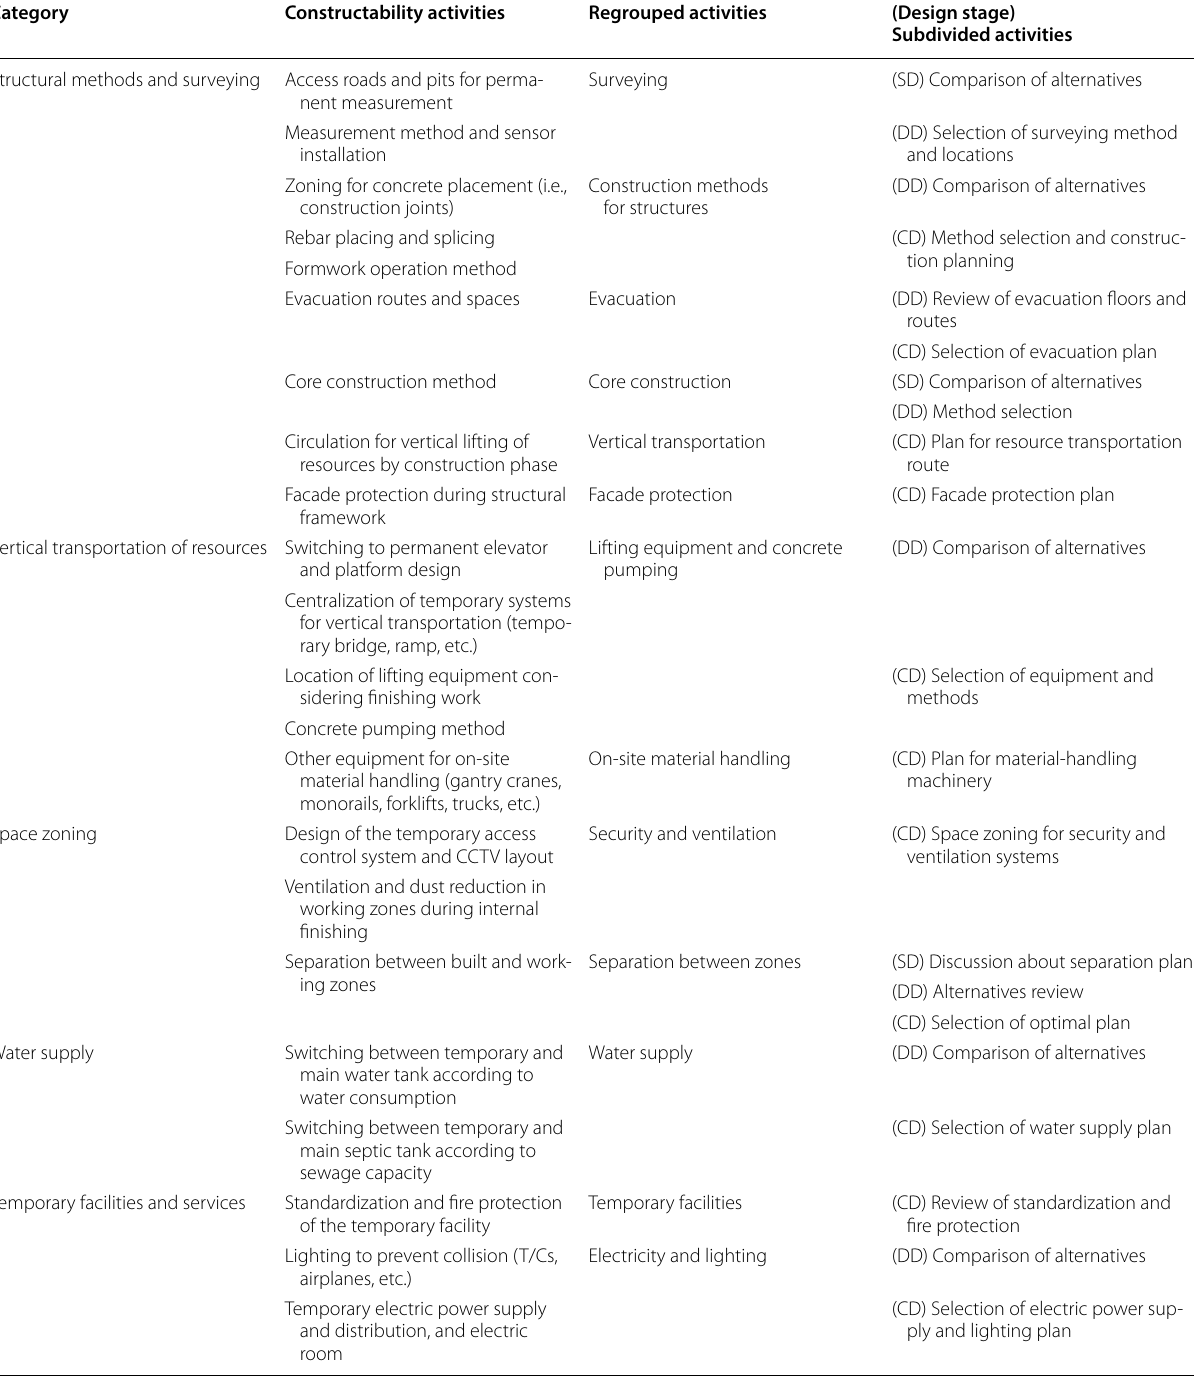
Table 2 Constructability activities for temporary work and regrouping for integration with design activities. Modified from Lee et al. (2017a;